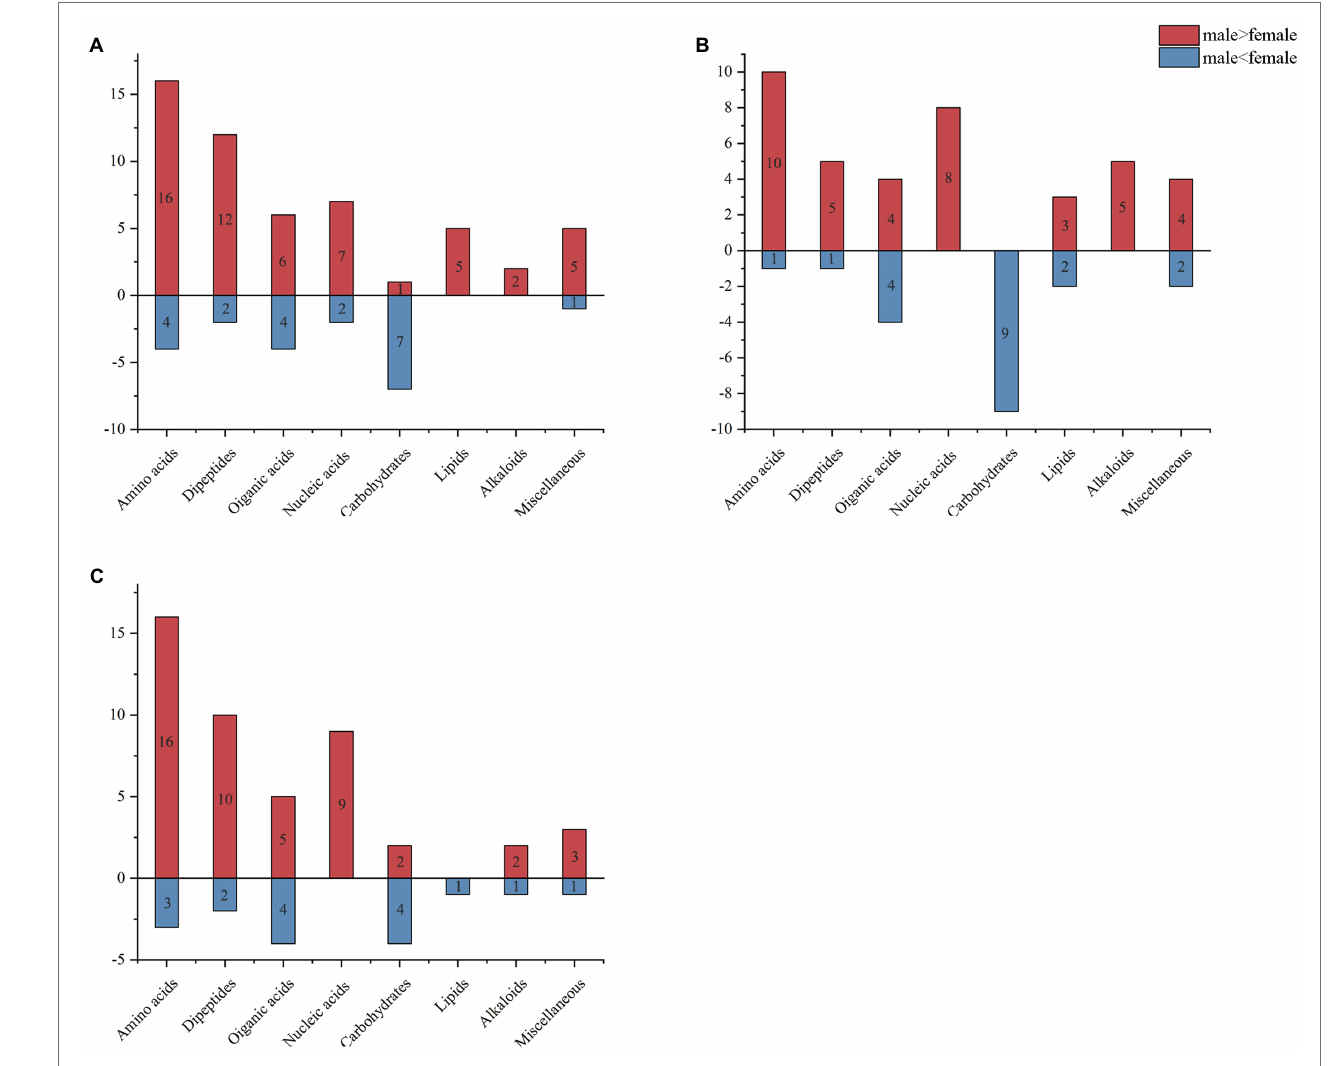
FIGURE 2 | Metabolite analysis of male and female Sargassum thunbergii macroalgae under different UV-B radiation intensities. Male and female Sargassum thunbergii in (A) control group; (B) under low UV-B radiation conditions; and (C) under high UV-B radiation conditions. Red rectangle represents metabolite content in males significantly higher than females. Blue rectangle represents metabolite content in females significantly higher than